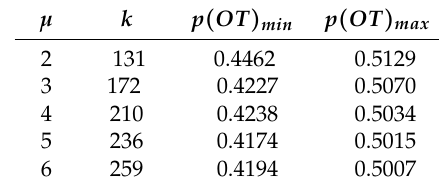
protocol. p ( OT ) min and p ( OT ) max 1